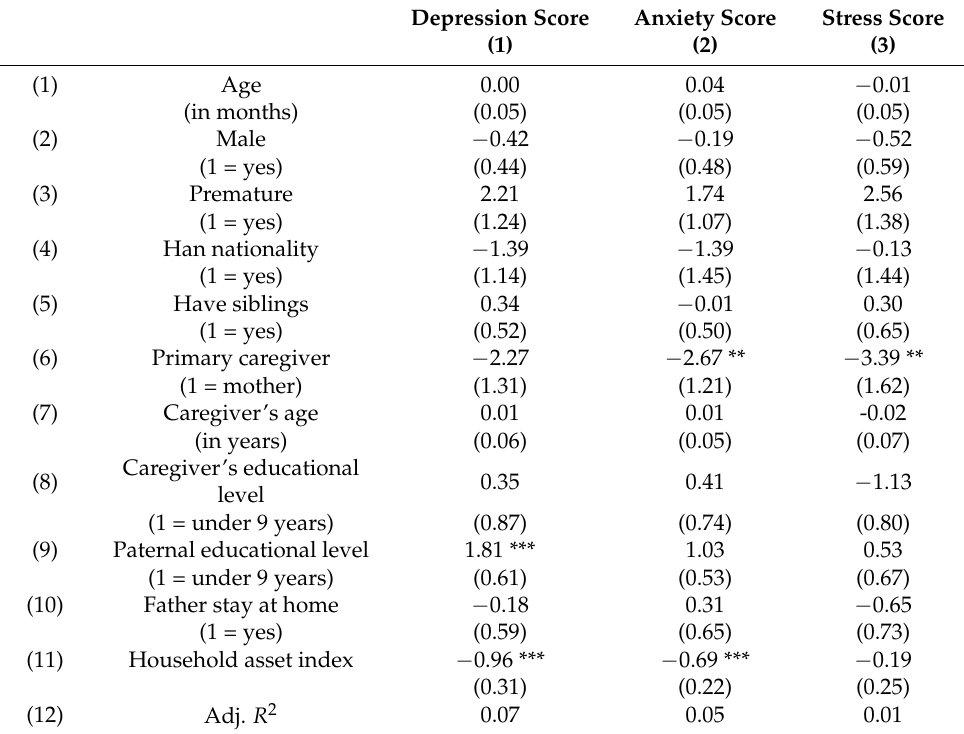
Table 4. Analysis of the influence of child and household characteristics on caregiver’s mental health, n =